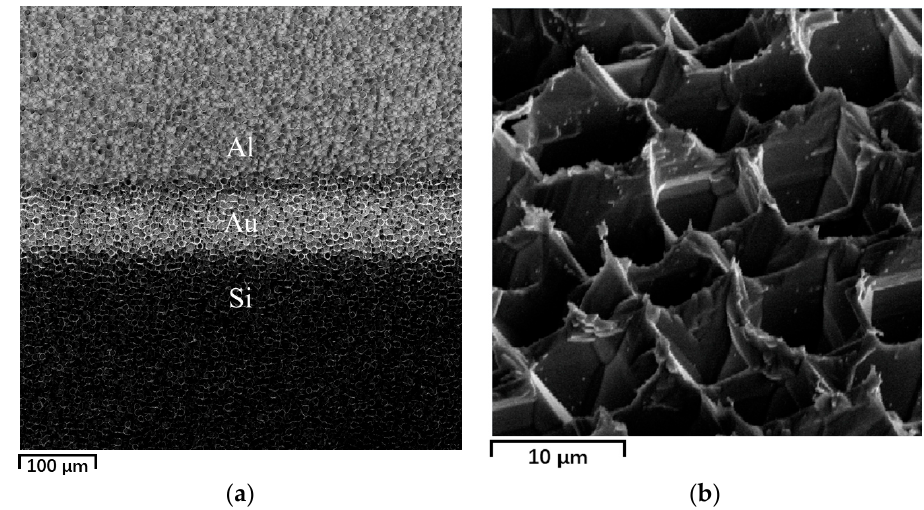
Figure 5. SEM micrographs of the treated sensors. ( a ) Short-circuited electrode (viewed at 0°). ( b ) Surface morphology after annealing (viewed at 45°).